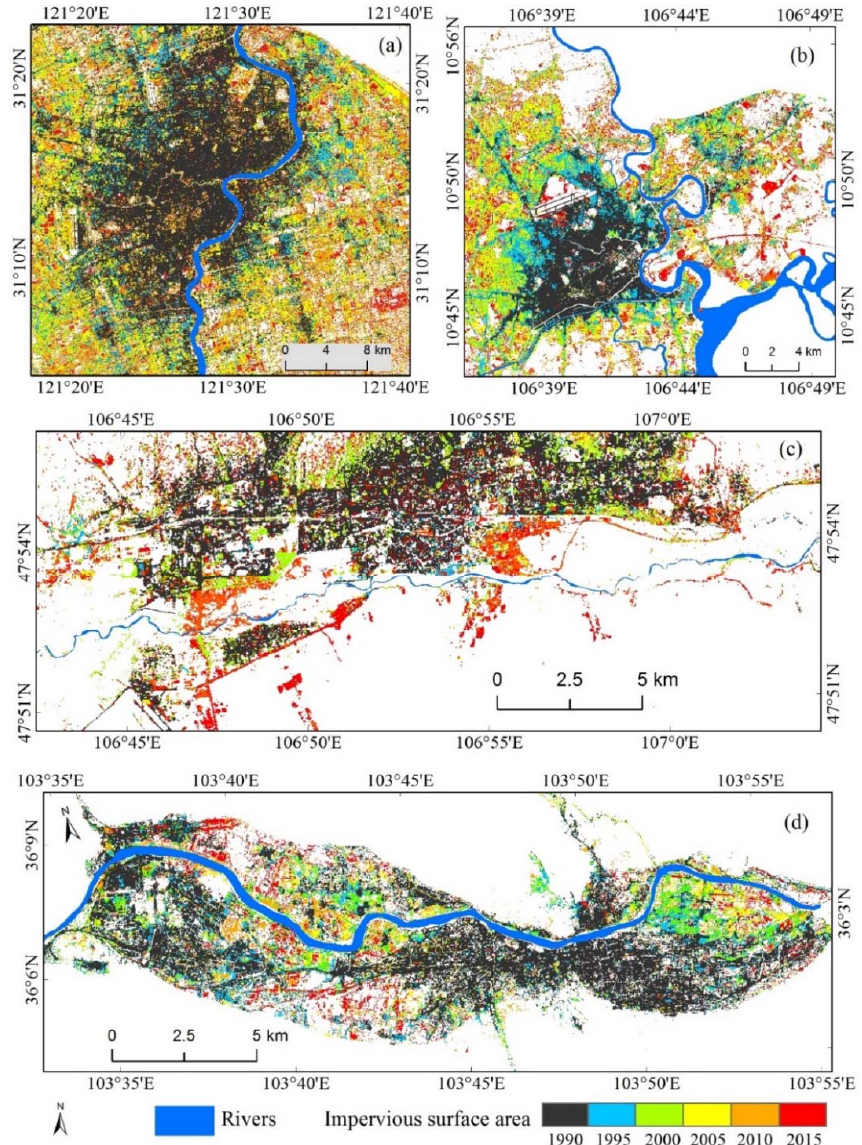
Figure 10. Comparison of the impact of rivers on urbanization spatial patterns between coastal and inland metropoles; examples are ( a ) Shanghai, ( b ) Ho Chi Minh City, ( c ) Ulaanbaatar, and ( d ) Lanzhou. The ISA in Ulaanbaatar was mainly distributed in the north side within the 2–5 km buffer zone away from the river. There were many non-ISAs (bare soils, sand/rocks, and grass) within the 1 km zone from the river, and the ISA density there was less than 0.2. The main ISA expansion was to the north, while the ISA expansion to the south was very slow, mainly near the airport with ISA density of less than 0.2 (Figure 10c). In Lanzhou, the urban area was mainly distributed in the southern region within 1–5 km from Yellow River in 1990. Since then, urban expansion has occurred in an eastern direction, south of the river, and western direction on both sides of the river (Figure 10d). In recent years, more ISA expansion has occurred on the north side of the westerner part of the city. Figure 11 indicates that rivers were constraining factors that limited ISA expansion from one side to the other. However, bridges diminished the constraints and promoted urban expansion over time to both sides of the rivers. For example, in the 1990s, Huangpu River in Shanghai caused ISA distribution on the west and east sides to be considerably different (Figure 11a1 vs. Figure